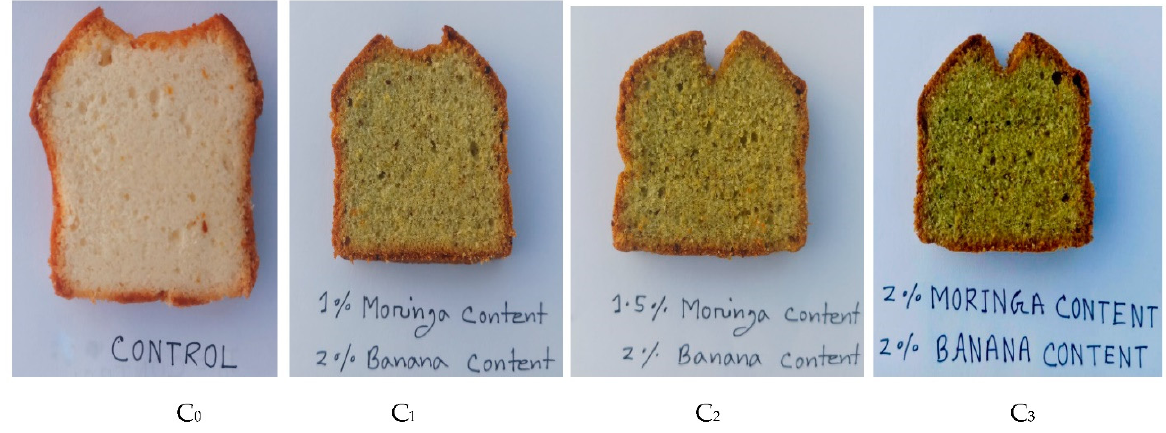
Figure 3. Cake ( C 0 ): 100% wheat flour (control); Cake ( C 1 ): 97% wheat flour, 1% MOLP, 2% RBF; Cake ( C 2 ): 96.5% wheat flour, 1.5% MOLP, 2% RBF; Cake ( C 3 ): 96% wheat flour, 2% MOLP, 2% RBF.